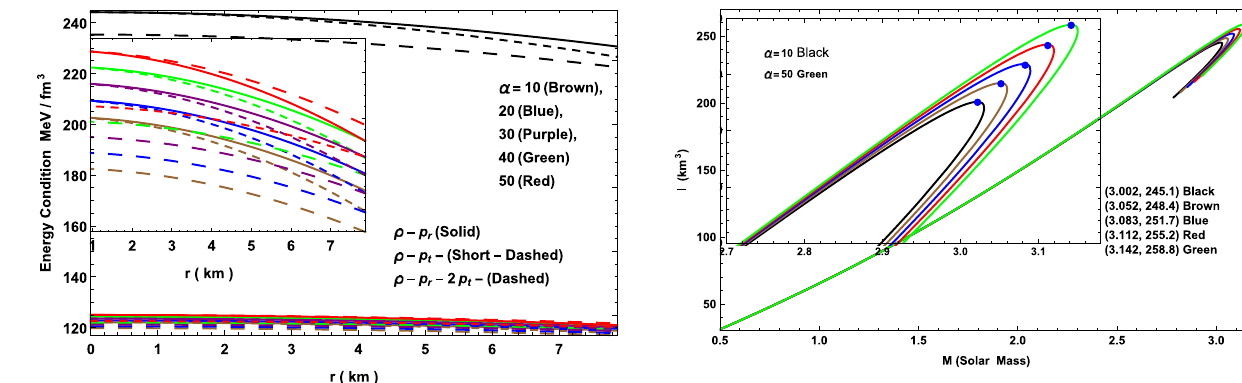
Fig. 10 Variation of energy conditions for 4U 1538-52 using the parameter provided in Table 1